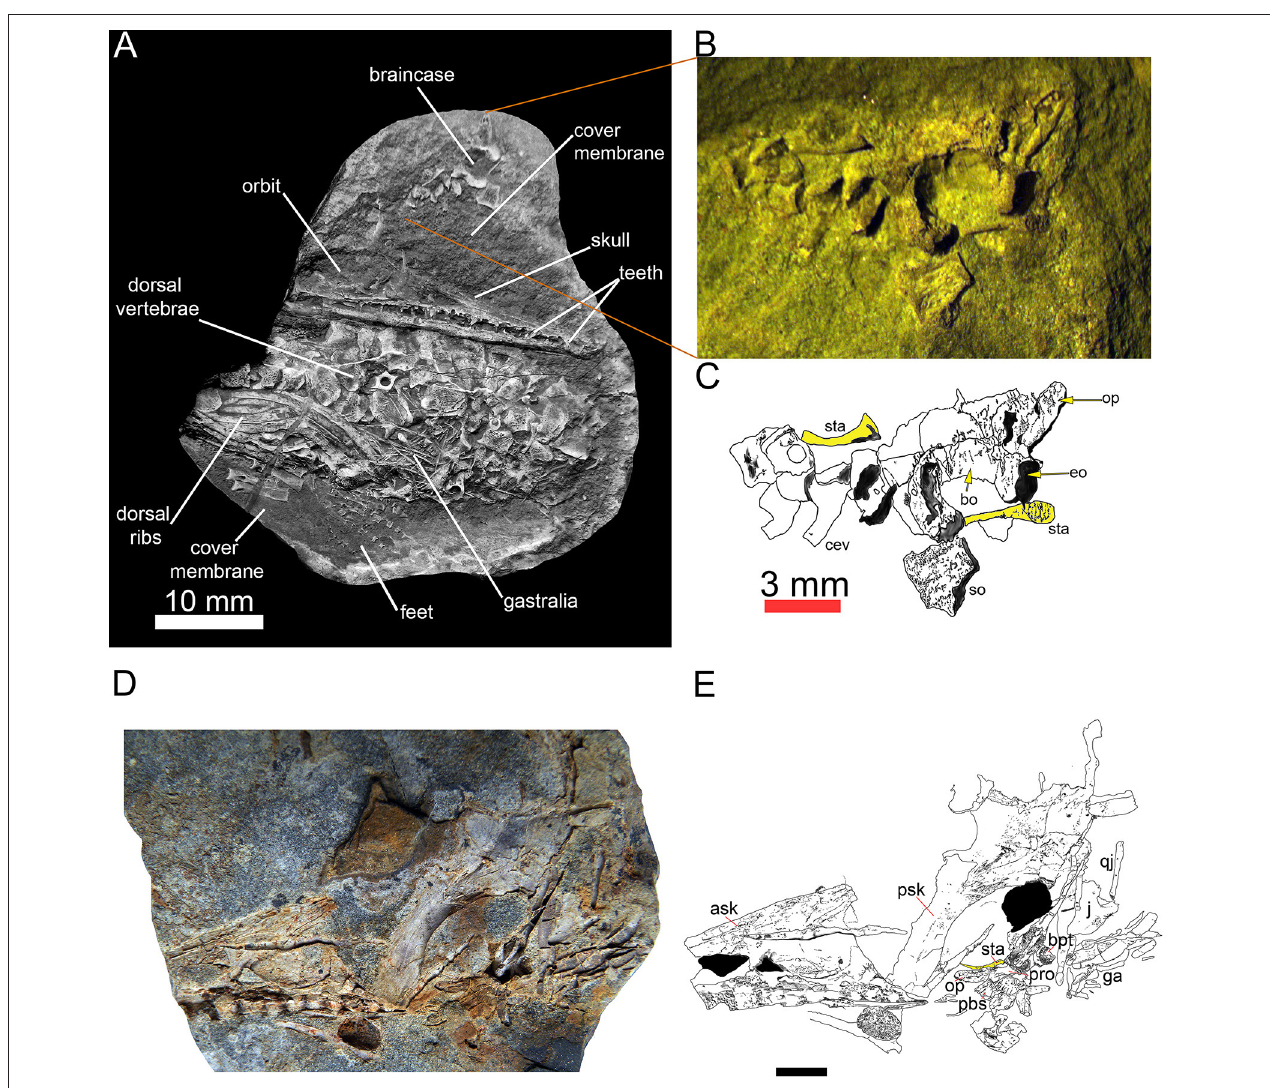
FIGURE 3 | Two specimens of Mesosaurus tenuidens with the stapes. Almost complete fetus at an advanced stage of development (FC-DPV 2504) in (A) general view, with a picture (B) and labeled line drawing (C) of the braincase, including occipital elements and stapes, which have been displaced from the rest of the specimen. Picture (D) and labeled line drawing (E) of a second, almost complete but slightly disarticulated adult specimen (FC–DPV 3067) showing the braincase with the right stapes approximately in its anatomical position (though its distal tip has moved anteriorly). In the interpretive drawings (C,E) , the stapes is highlighted in yellow. Both specimens are from the Early Permian Mangrullo Formation of Uruguay. Scale for (D,E) 10mm. Anatomical abbreviations: ask, anterior skull; bo, basioccipital; bpt, basipterygoid; cev, cervical vertebrae; eo, exoccipital; ga, gastralia; op, opistotic; pbs, parabasisphenoid; pro, prootic; psk, posterior skull;